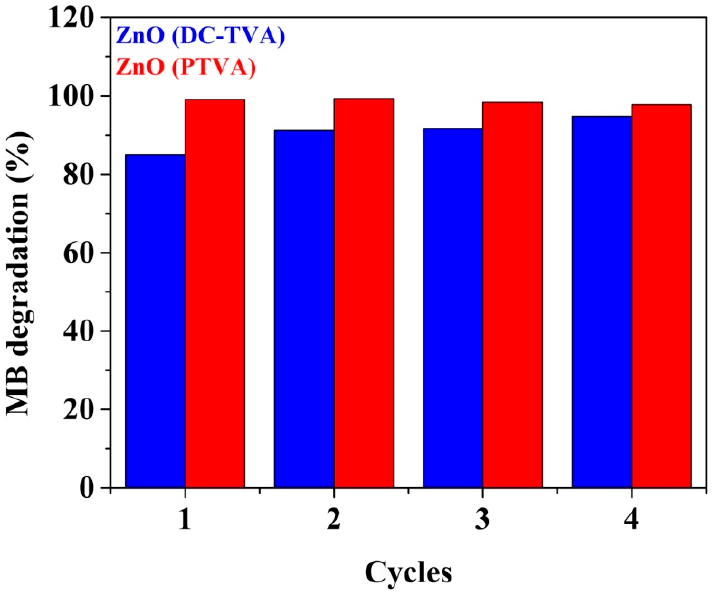
Figure 7. Reuse of ZnO synthesized by DC-TVA and PTVA approaches for the photodegradation of MB for four successive cycles (240 min each run).